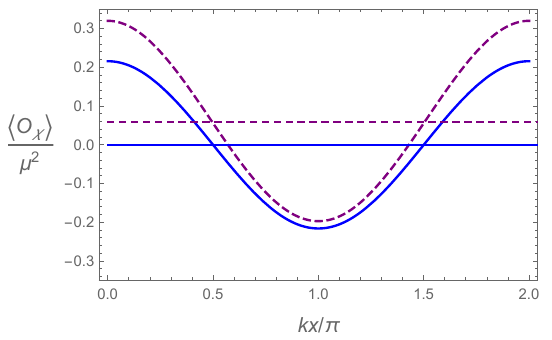
Figure 12 . The scalar condensate for T = 0 : 01426 and k = 1. The solid blue curve corresponds to q B = 0 and the dashed one is for q B = 0 : 5. Two horizontal lines denote their average values.